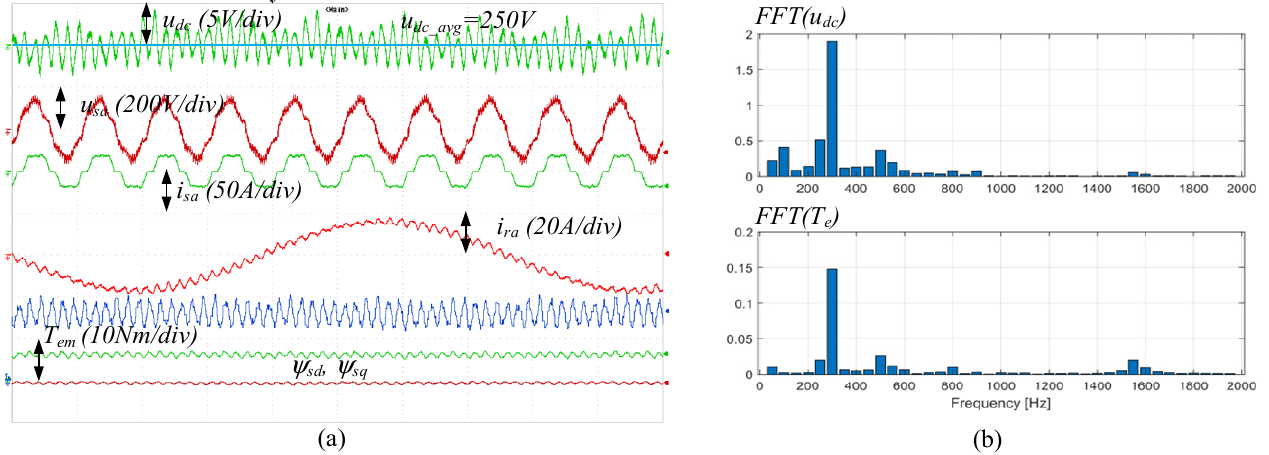
Figure 9. Experimental results of a small-power DFIG-DC system for field-oriented control FOC ( a ) and the FFT results of DC-bus voltage and torque oscillations for this method ( b ). Table 1. Torque and DC Voltage Pulsations Obtained in Simulation and Experiment.